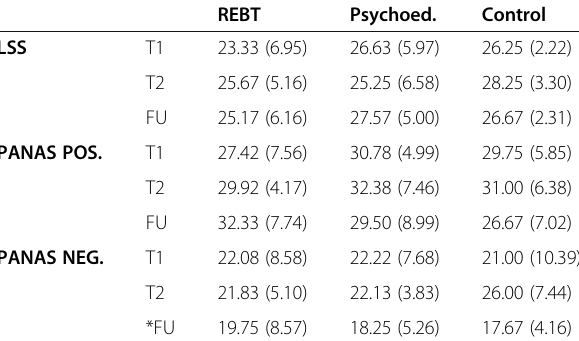
Table 3 Descriptive and multiple comparisons data of the life satisfaction and positive and negative affects in all phases (pre and post-intervention and follow-up) REBT